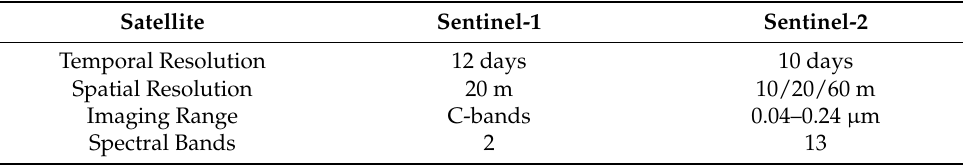
Table 1. Key parameters of the multi-source satellite data within the dataset.